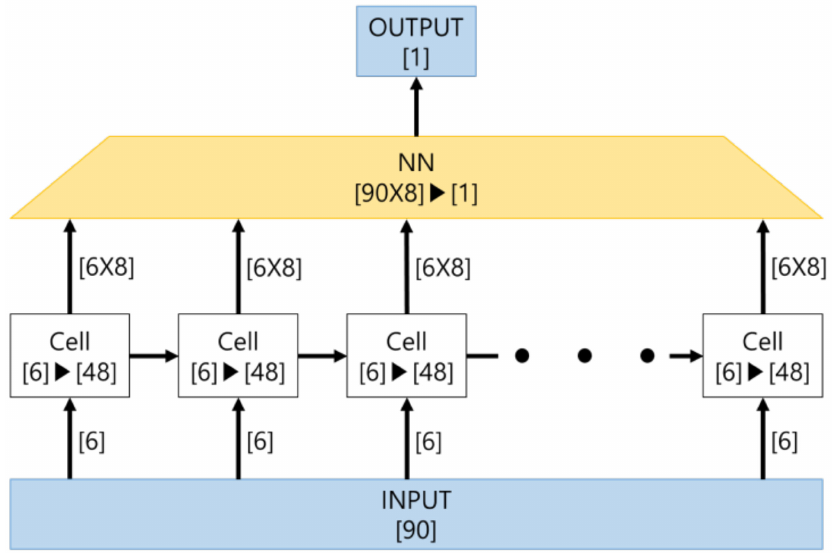
Figure 10. The structure of LSTM in this